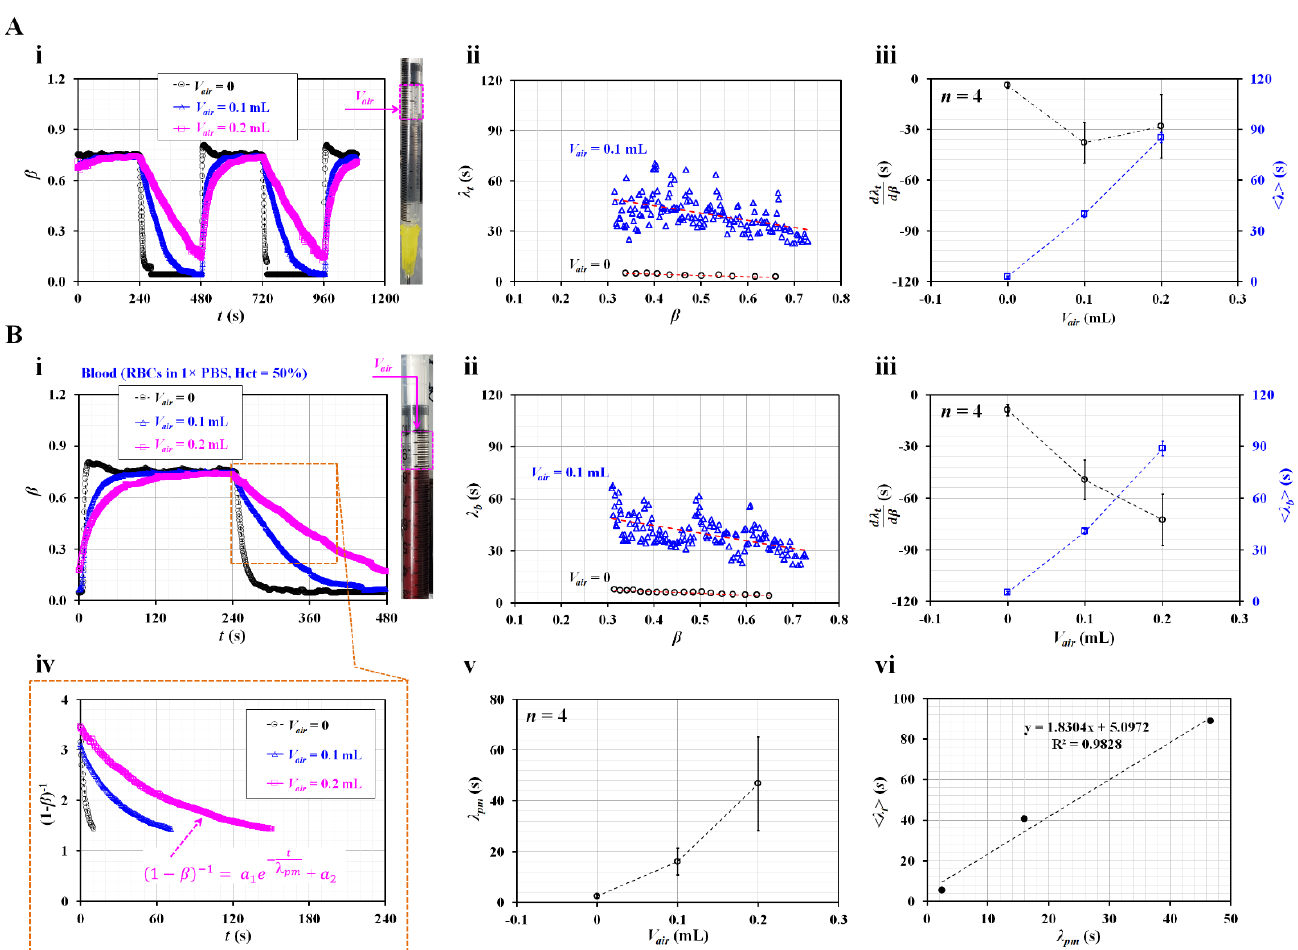
Figure 4. Contribution of air cavity secured inside the driving syringe ( V air ) to the time constant. ( A ) Contributions of V air to the time constant of glycerin (30%). ( i ) Temporal variations in β with respect to V air = 0, 0.1, and 0.2 mL. The right-hand panel shows the air cavity secured over glycerin (30%) inside the drying syringe. ( ii ) Variations in λ t with respect to β and V air . ( iii ) Variations in d λ t and < λ t > with respect to V air . ( B ) Contribution of V air to the time constant of blood. Here, blood (Hct = 50%) was prepared by adding normal RBCs into 1 × PBS. ( i ) Temporal variations in β with respect to V air = 0, 0.1, and 0.2 mL. The right-hand panel shows the air cavity secured above blood inside the drying syringe. ( ii ) Variations in λ t with respect to β and V air . ( iii ) Variations in d λ t < λ t > with respect to V air . ( iv ) Temporal variations in (1 − β ) − 1 with respect to V air . Here, the variation in (1 − β ) − 1 was best fitted as (1 − β ) − 1 = a 1 exp (– t / λ pm ) + a 2 . ( v ) Variations in λ pm with respect to V air . ( vi ) Linear relationship between < λ t > (present method) and λ pm (previous